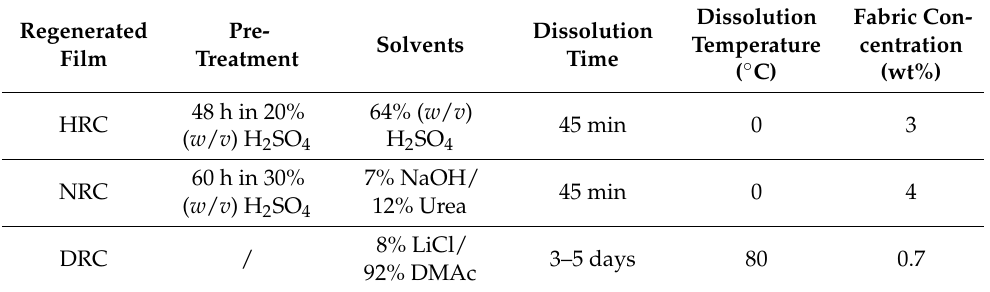
Table 1. Dissolution conditions of waste cotton–elastane fabric in three solvent